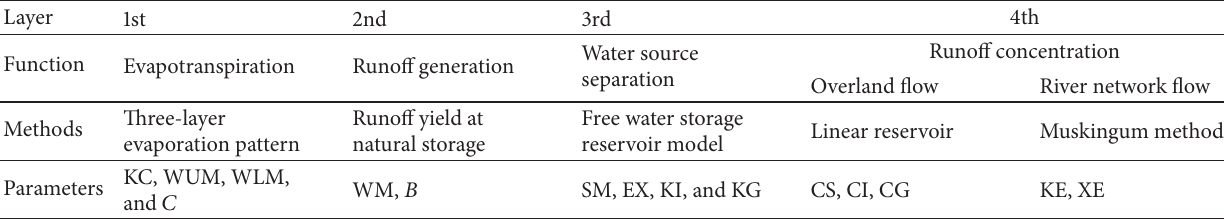
Table 1: Function, methods, and parameters in Xin’anjiang